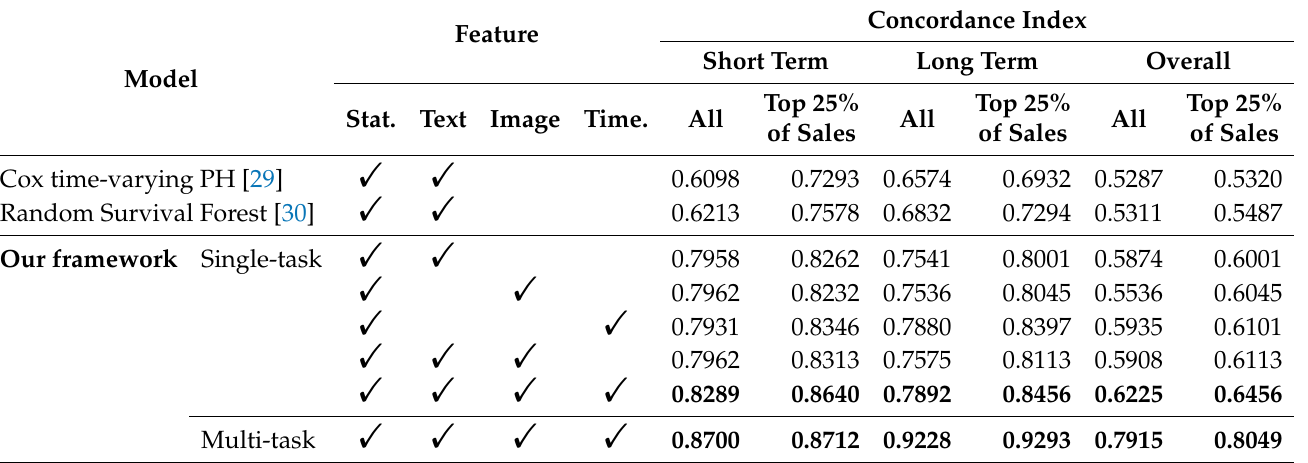
Table 4. Comparison of concordance indexes with different time intervals and different features. The time interval was compared for the short term, long term, and the whole period. We calculated the concordance indexes using the prediction for all test data and the prediction for the top 25% of sales data in the test data. Concordance Index Feature Short Term Long Term Overall Model Stat. Text Image